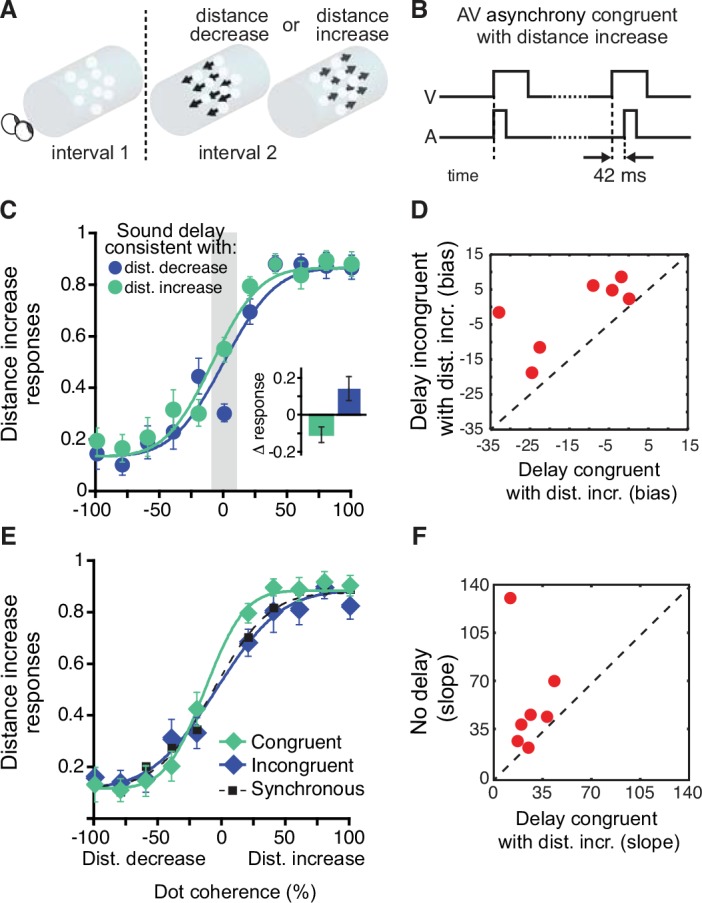
Experiment 2.(A) Experimental design. In the first interval, a dot cluster was presented at the reference distance. In the second interval, the disparity of the dot cluster was either increased or decreased, corresponding to a distance change of ~13 cm. The illustration shows shifts at 100% coherence. (B) Stimulus timeline. Sounds were either synchronous with the onset of the visual stimulus (first period in this example) or delayed by 42 ms (second period). Shown here is a trial in which the sound delay is consistent with a visual distance increase. (C) Bias. Proportion of times that subjects reported the second stimulus as being more distant, plotted as a function of dot coherence. Trials in which sound delays were consistent with distance increase are shown in light green symbols while trials consistent with a distance decrease are shown in dark blue symbols. Curves show psychometric functions fitted to the data. Participants were more likely to perceive a distance increase when sound delays were presented in the second interval (i.e., ecologically consistent with a distance increase). Inset shows changes in percent response to ambiguous (i.e., incoherent) stimuli (shaded area) plotted relative to the results of the audiovisually synchronous control condition. Error bars are SEM. (D) Data for individual participants (shown as averaged in panel C). Bias terms of psychometric functions (i.e., Gaussian mean). This plot contrasts performance in trials when sound delays were consistent with distance increases with those consistent with distance decreases (units are % coherence). Points above the unity line indicate bias towards perceiving a distance increase when the delay occurred in the 2nd interval. (E) Precision. Same data as in panel C but divided into the conditions where visual and auditory cues were congruent (light green diamonds) or incongruent (dark blue diamonds). The synchronous control condition is plotted as small black squares. (F) Data for individual participants (shown as averaged in panel E). Slope terms of psychometric functions (i.e., Gaussian standard deviation). This plot contrasts data from trials with ecologically congruent stimulus-delay pairings with data from the synchronous condition (units are % coherence). Points above the unity line indicate higher precision when visual distance changes were congruent with distance changes implied by sound delays.